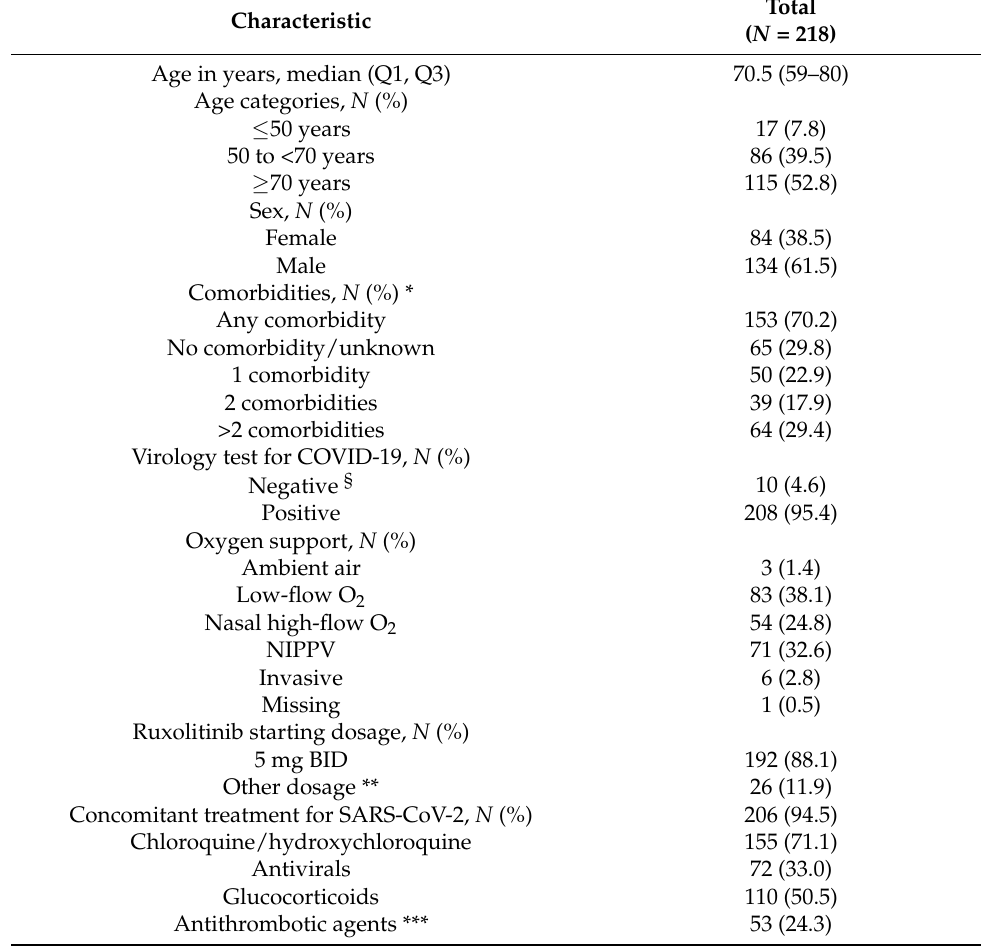
Table 2. Baseline characteristics of